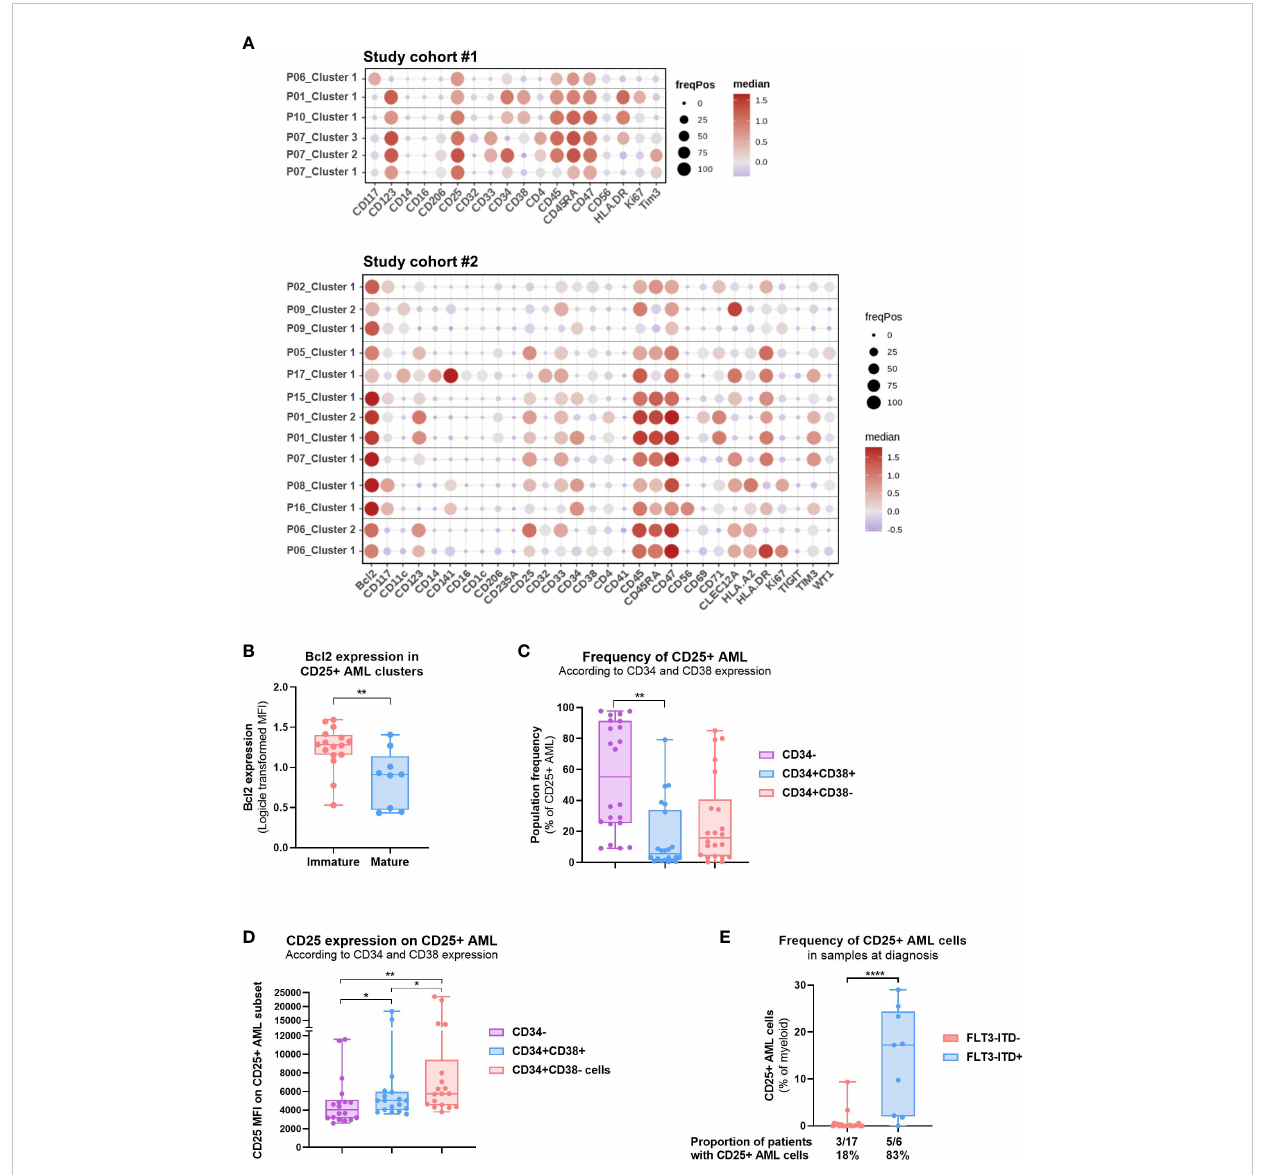
FIGURE 4 Patient-centric approach allows the phenotypic analysis of CD25+ AML clusters. (A) Dot plot depicting the per patient phenotypic analysis of CD25+ AML clusters identi fi ed in 14 patients in Study #1 (top) and Study #2 (bottom). See Methods for details. Color code indicates the median expression (logicle transformed MFI); point size indicates the fraction of cells positive for each marker. (B) Bcl-2 expression (logicle transformed MFI) in CD25+ AML clusters identi fi ed in Study #2. Unpaired t test. (C) Frequency of CD25+ AML subsets de fi ned according to CD34 and CD38 expression (CD34-, CD34+CD38+, CD34+CD38-) in the 14 pre-selected patients shown in (A) Data compiled from BMMC and PBMC samples analyzed in Study #1 and #2. One-way ANOVA, Tukey ’ s multiple comparison test. (D) CD25 expression (MFI) on CD25+ AML subsets de fi ned according to CD34 and CD38 expression (CD34-, CD34+CD38+, CD34+CD38-). Data compiled from BMMC and PBMC samples analyzed in Study #2. One-way ANOVA, Tukey ’ s multiple comparison test. (E) Abundance of CD25+ AML cells in treatment naïve PBMC or BMMC samples according to the FLT3-ITD status. Data compiled from Study #1 and #2. Unpaired t test. The proportion of patients for which CD25 expression was detected on AML cells is shown below the bar graph. Signi fi cance levels are de fi ned in the methods section. P values > 0.05 are not indicated on the graphs. BM: Bone marrow; HSC: Hematopoietic stem cell; Chemo: Chemotherapy; HMA: DNA Hypomethylating Agent; VEN: venetoclax; FLT3-ITD: Internal tandem duplications (ITDs) in the fms-like tyrosine kinase 3 (FLT3) gene. Signi fi cance levels are indicated as follows: ns or not indicated, not signi fi cant, P > 0.05; *P